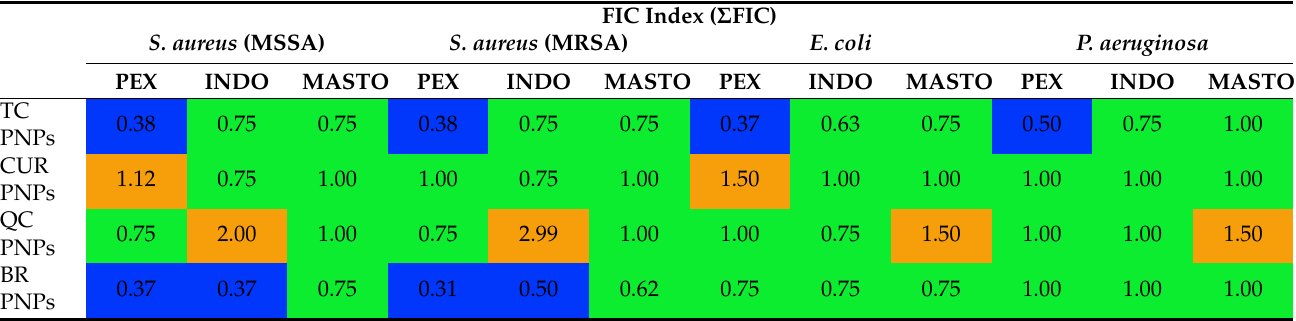
Table 2. FIC index ( Σ FIC) values for SrtAI-loaded (TC, CUR, QC, BR) PNPs combined with AMPs (PEX, INDO and MASTO) against S. aureus (ATCC 25923), E. coli (ATCC 25922), P. aeruginosa (ATCC 27853), and MRSA (ATCC 43300), as measured using a checkerboard assay. Cell colors indicate syner- gistic (blue), additive (green) and indifferent (orange) combinations. To demonstrate reproducibility, each experiment was performed three times. FIC Index ( Σ